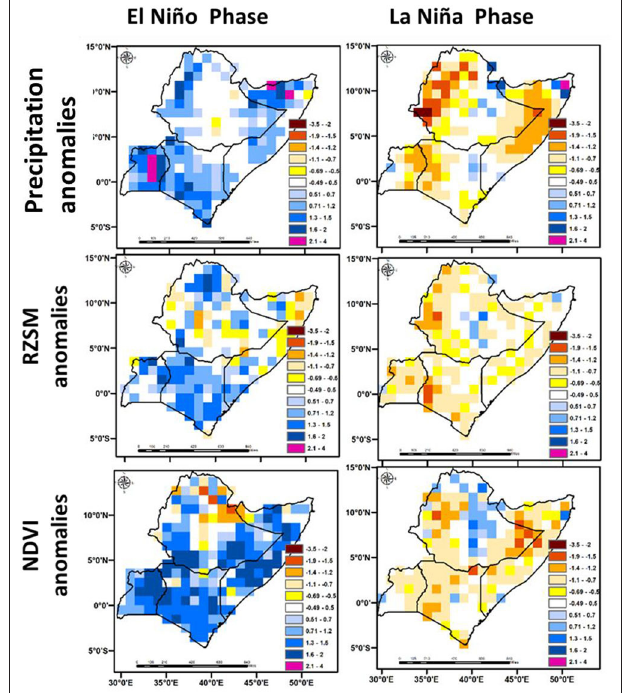
FIGURE 3 | Standardized precipitation, root-zone soil moisture and NDVI anomalies at peak El Niño (top) condition from November 2015 to January 2016 and La Niña condition (bottom) from November 2016 to January 2017 in Southern Africa.